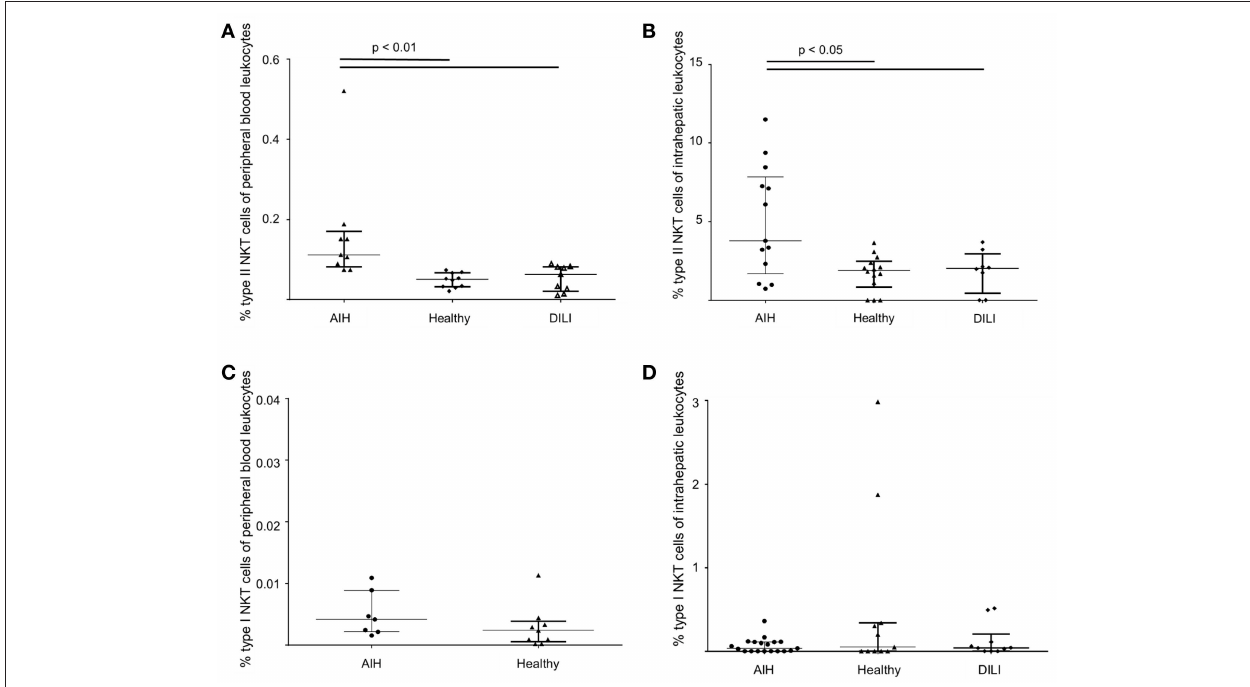
FIGURE 3 | Increased frequency of sulfatide-reactive type II NKT cells in patients with autoimmune hepatitis. The frequency of peripheral blood (A) and intrahepatic (B) type II NKT cells and peripheral blood (C) and intrahepatic (D) type I NKT cells in AIH patients in comparison to healthy subjects and patients with DILI is shown.